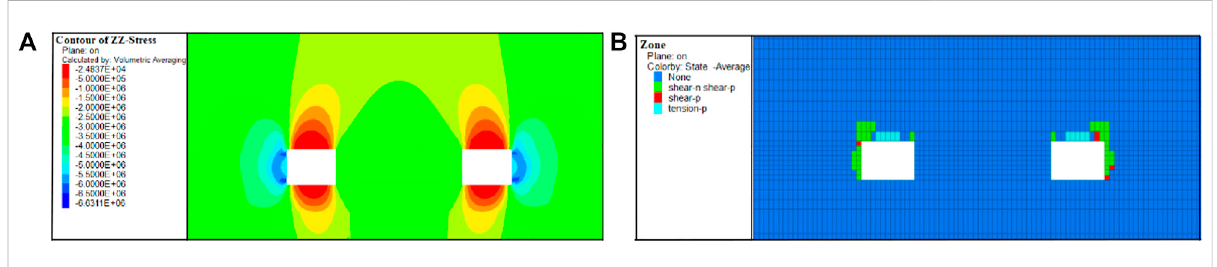
FIGURE 9 Distribution of vertical stress and plastic zones in branch roadways and the arti fi cial pillar. (A) Vertical stress distribution of the branch roadway and arti fi cial pillar; (B) distribution of plastic zones of the branches and arti fi cial pillar.